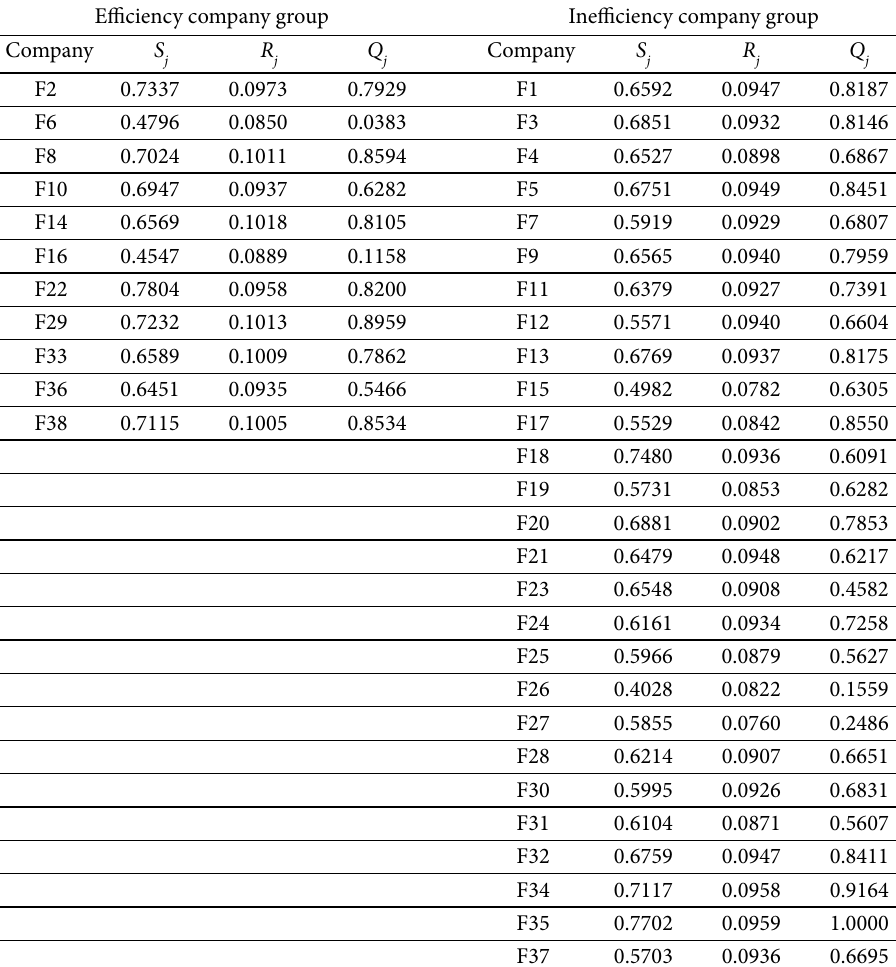
Table 9. The values of S , R and Q for efficient and inefficient companies groups Efficiency company